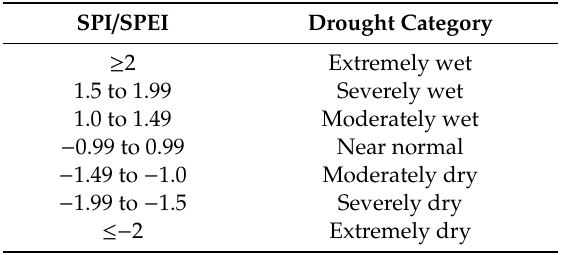
Table 2. Classification of meteorological drought expressed by standardized precipitation index (SPI) and standardized precipitation-evapotranspiration index (SPEI)